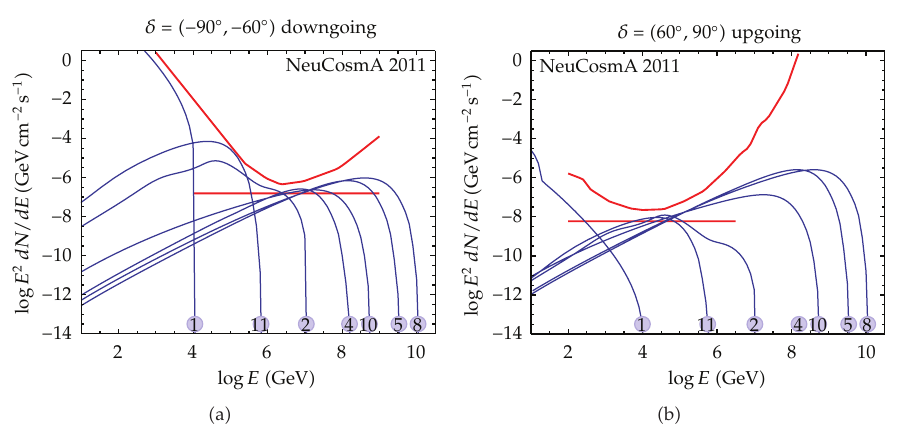
Figure 8: Limits for selected muon neutrino spectra (cid:3) including flavor mixing (cid:4) from (cid:5) 34 (cid:6) for di ff erent declination bands for the time-integrated point source search in IC40 (cid:3) 90% CL (cid:4) (cid:5) 13 (cid:6) . The thick lines show the limits for an E − 2 ν flux (cid:3) in the dominant energy range (cid:4) , and the thick curves the di ff erential limits,